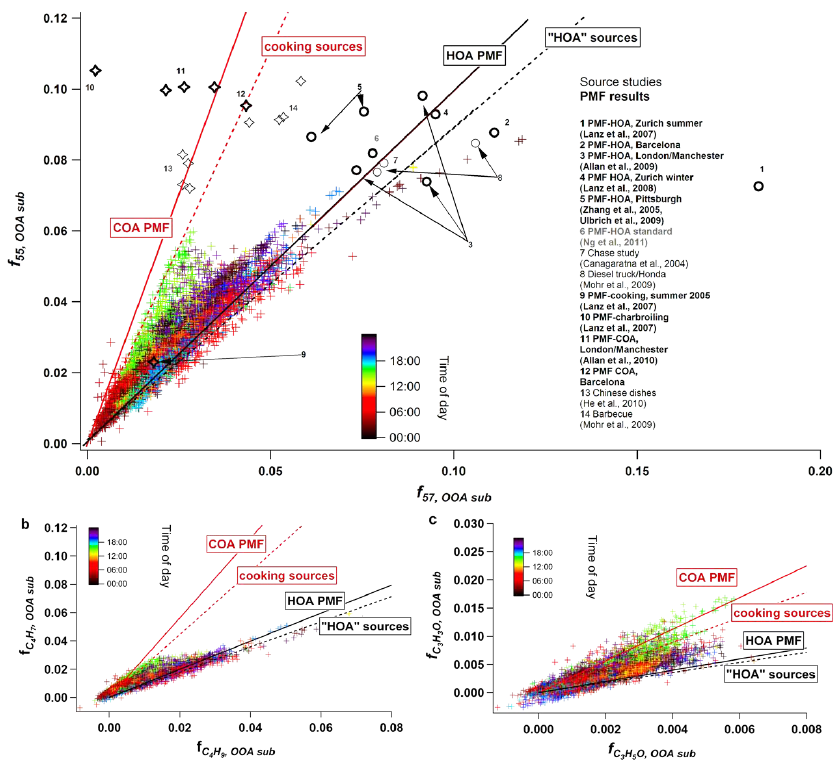
Fig. 6. f 55 , OOAsub (see text) plotted against f 57 , OOAsub (a) , f C f C (c) for the whole Barcelona dataset. Data points are colored according to time of day. Included in (a) are F 55 and 3 H 5 O + , OOAsub F 57 extracted from various PMF HOA and COA factors (bold symbols), as well as from cooking and traffic source emission studies (thin symbols), the lines represent the linear fits applied to each group. Note that axes are scaled differently for clarity